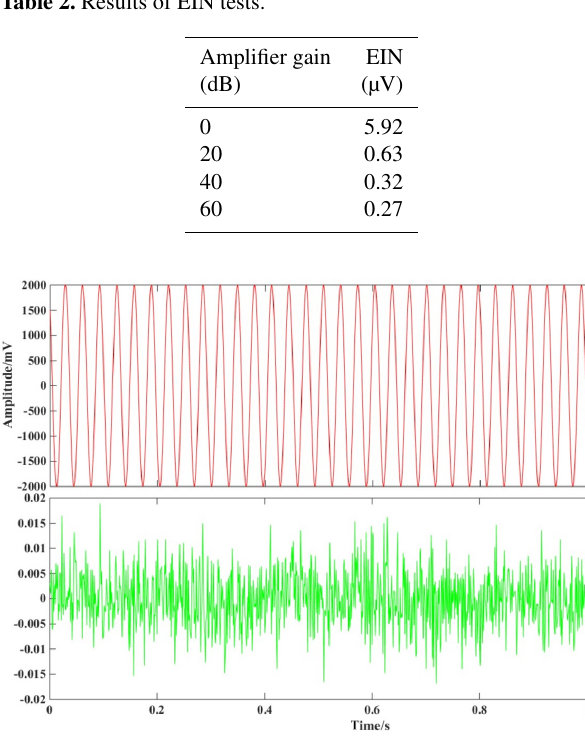
Figure 12. Time domain waveform of each channel during the first crosstalk test (red: seismic channel; green: electrical